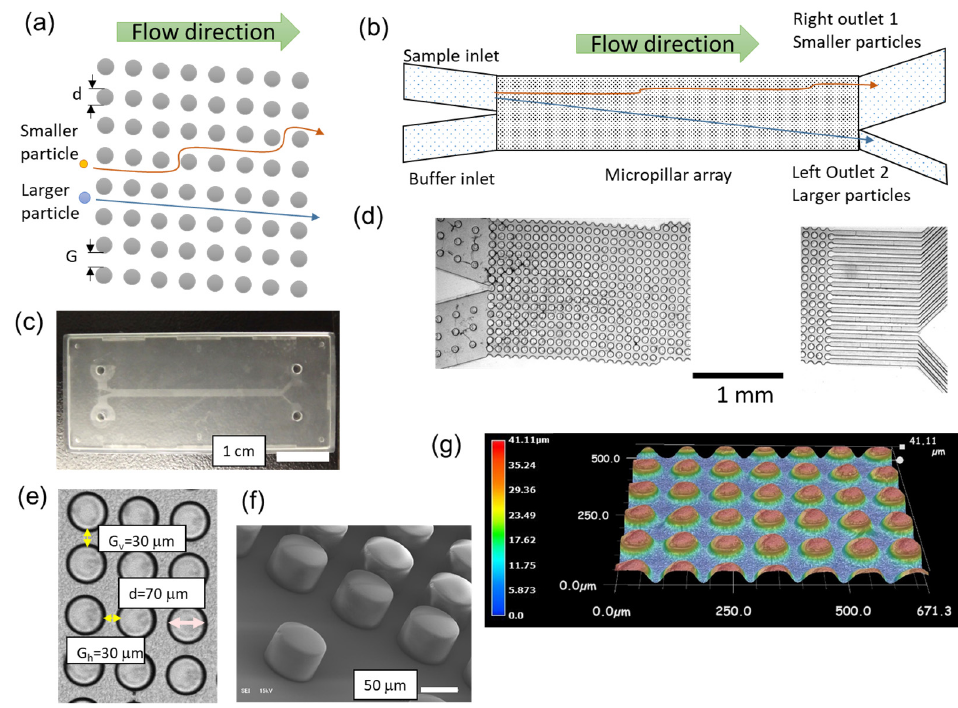
Figure 1. ( a ) Schematic of the deterministic lateral displacement (DLD) principle for particle separation. ( b ) Microfluidic channel arrangement in this study. ( c ) A photograph of the polypropylene (PP)-based microfluidic DLD device. The size of this chip is 25 mm × 58 mm. ( d ) Microscopic images of the inlets and outlets of the microfluidic DLD device (Chip 1). ( e ) An optical microscopy image showing the pillar size and gaps of the micropillars. ( f ) A SEM image of the micropillars. ( g ) A cross-section of the three-dimensional reconstructed image. A color contour shows the height of the microstructures. The heights of the pillars are approximately 40 μm.